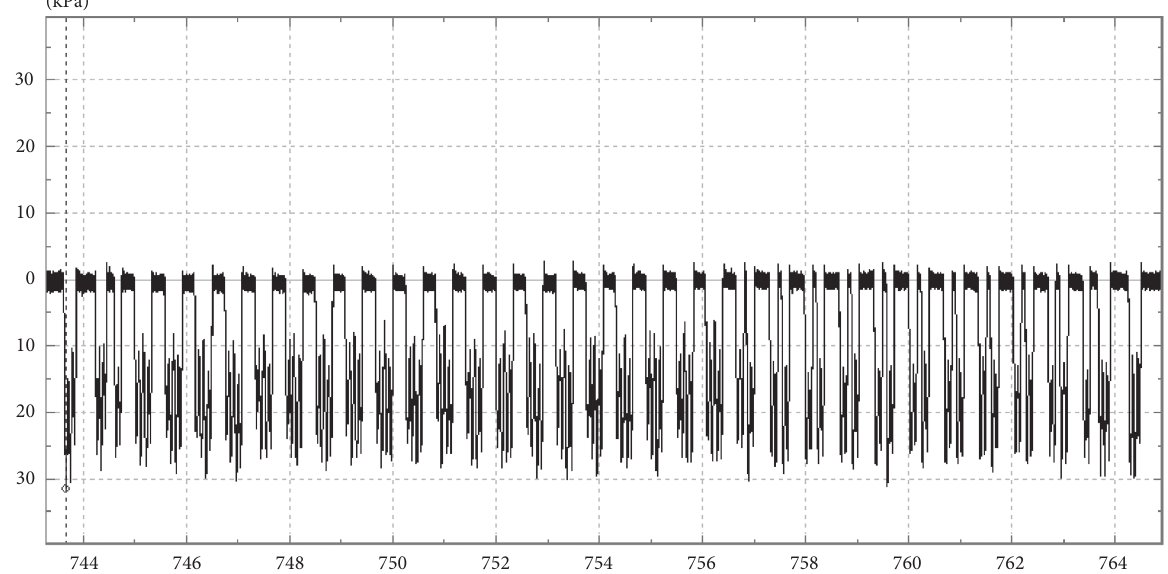
Figure 11: Vertical dynamic stress of track center on top of the invert filling layer in the repair zone.